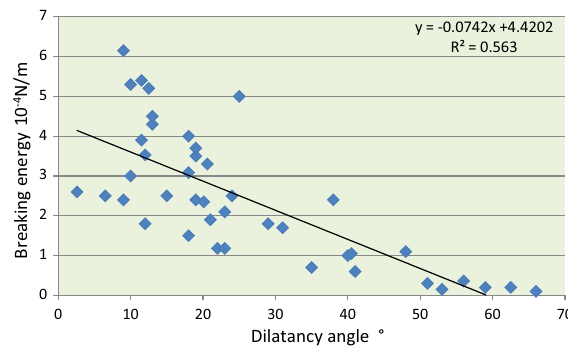
Fig. 12 Relationship between breaking energy and dilatancy